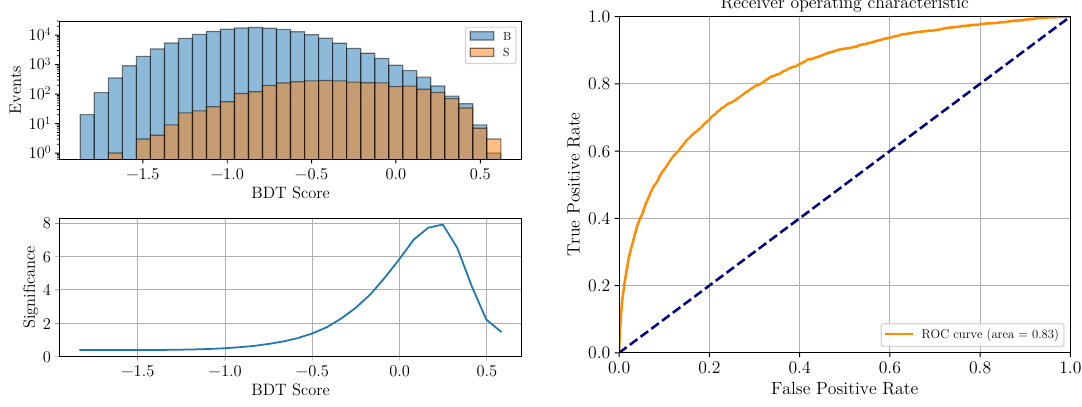
p S + B + ( (cid:15)B ) 2 for (cid:15) = 5% as a function of